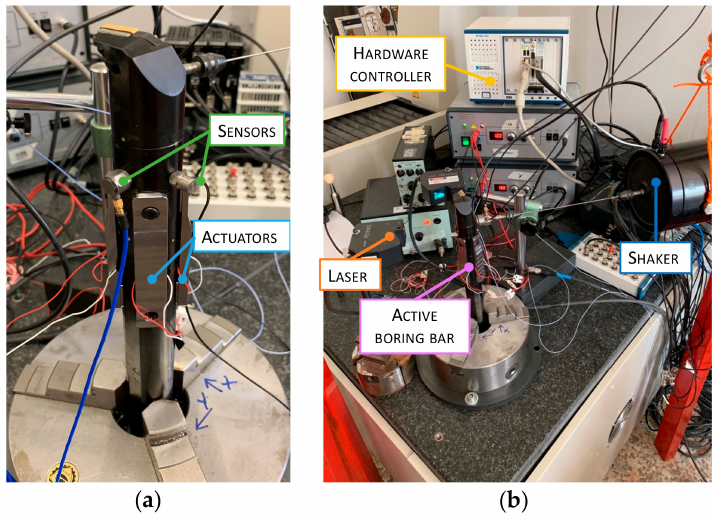
Figure 19. ( a ) Active Boring bar. ( b ) Experimental setup.